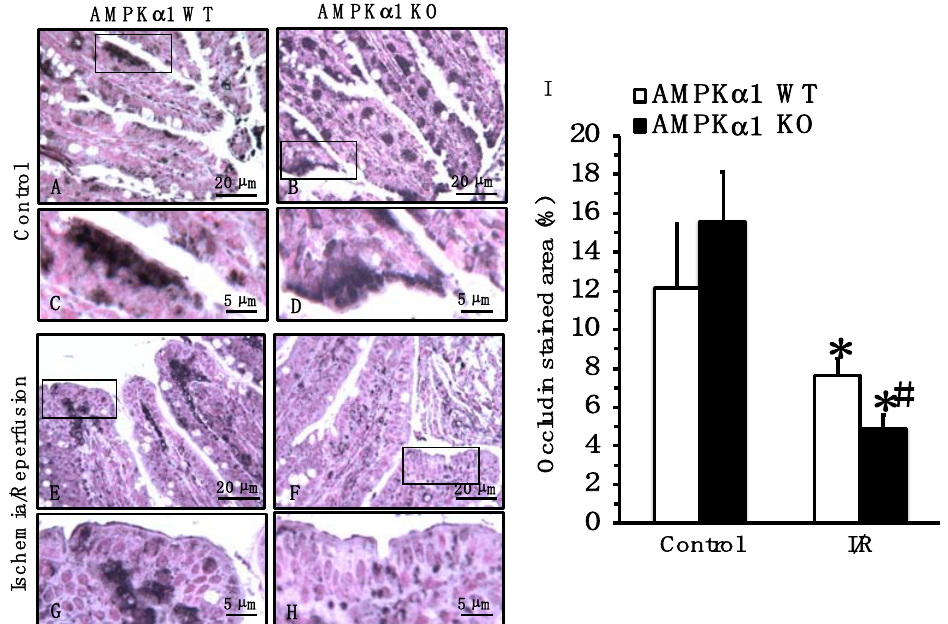
Figure 4. Effect of genetic deficiency of AMPK α 1 on gut localization of occludin. ( A – H ) Representa- tive photomicrographs of immunostaining of occludin in ileum sections. Black boxes in ( A , B , E , F ) indicate regions of magnified insets shown in ( C , D , G , H ). In control AMPK α 1 WT ( A , C ) and KO mice ( B , D ), occludin was mainly found on the epithelial membrane surface. At 4 h after mesenteric I/R, immunostaining moderately decreased in the villi of WT mice ( E , G ) but markedly decreased in KO mice ( F , H ) and was mainly confined in the center of the villi. ( I ) Quantitative analysis of stained area. Data are mean ± SEM of 4 animals for each group; * p < 0.05 versus control mice of the same genotype; # p < 0.05 versus WT group. Scale bars of ( A , B , E , F ): 20 µ m. Scale bars of ( C , D , G , H ): 5 µ